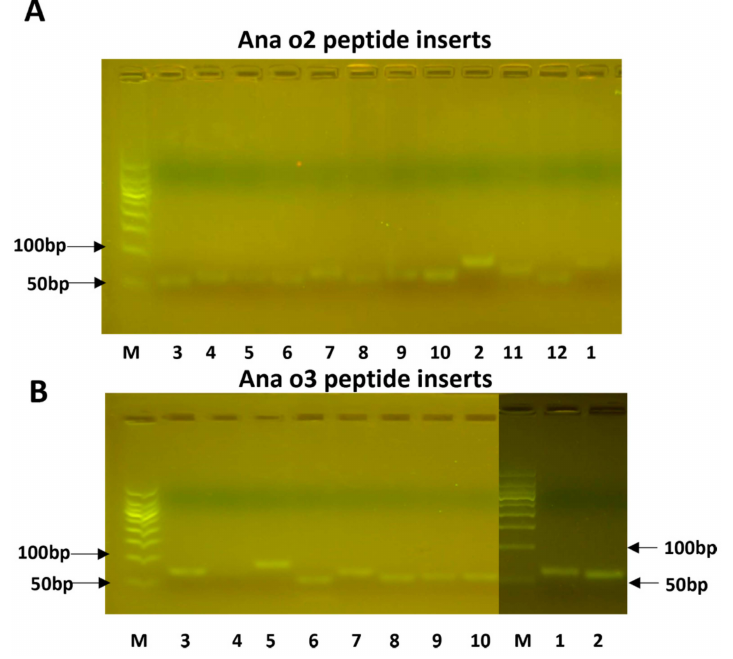
Figure 3. The cloned peptide inserts for Ana o 2 ( A ) and Ana o 3 ( B ). The numbers below the lanes correspond to the peptide numbers provided in Table 1. Lane M represents a size